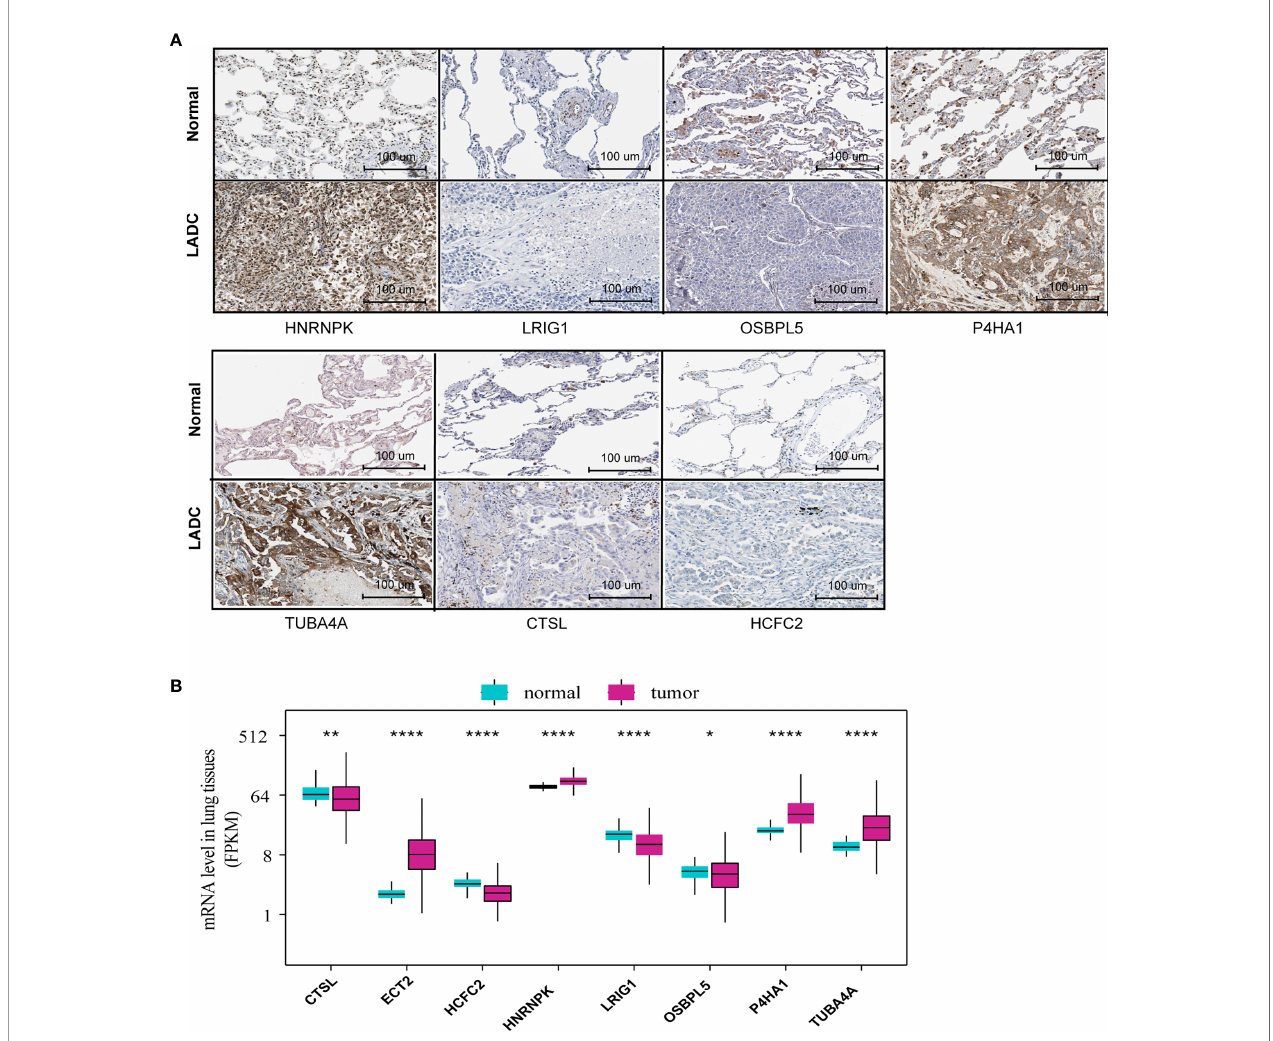
FIGURE 2 | MRG protein and mRNA level between normal and tumor tissues. (A) The MRG protein levels detected via immunohistochemistry provided by the HPA database (ETC2 was unavailable in HPA). (B) MRG mRNA levels of normal and tumor tissues based on RNA-Seq data from the training set *P<0.05, **P<0.01, ***P<0.001,